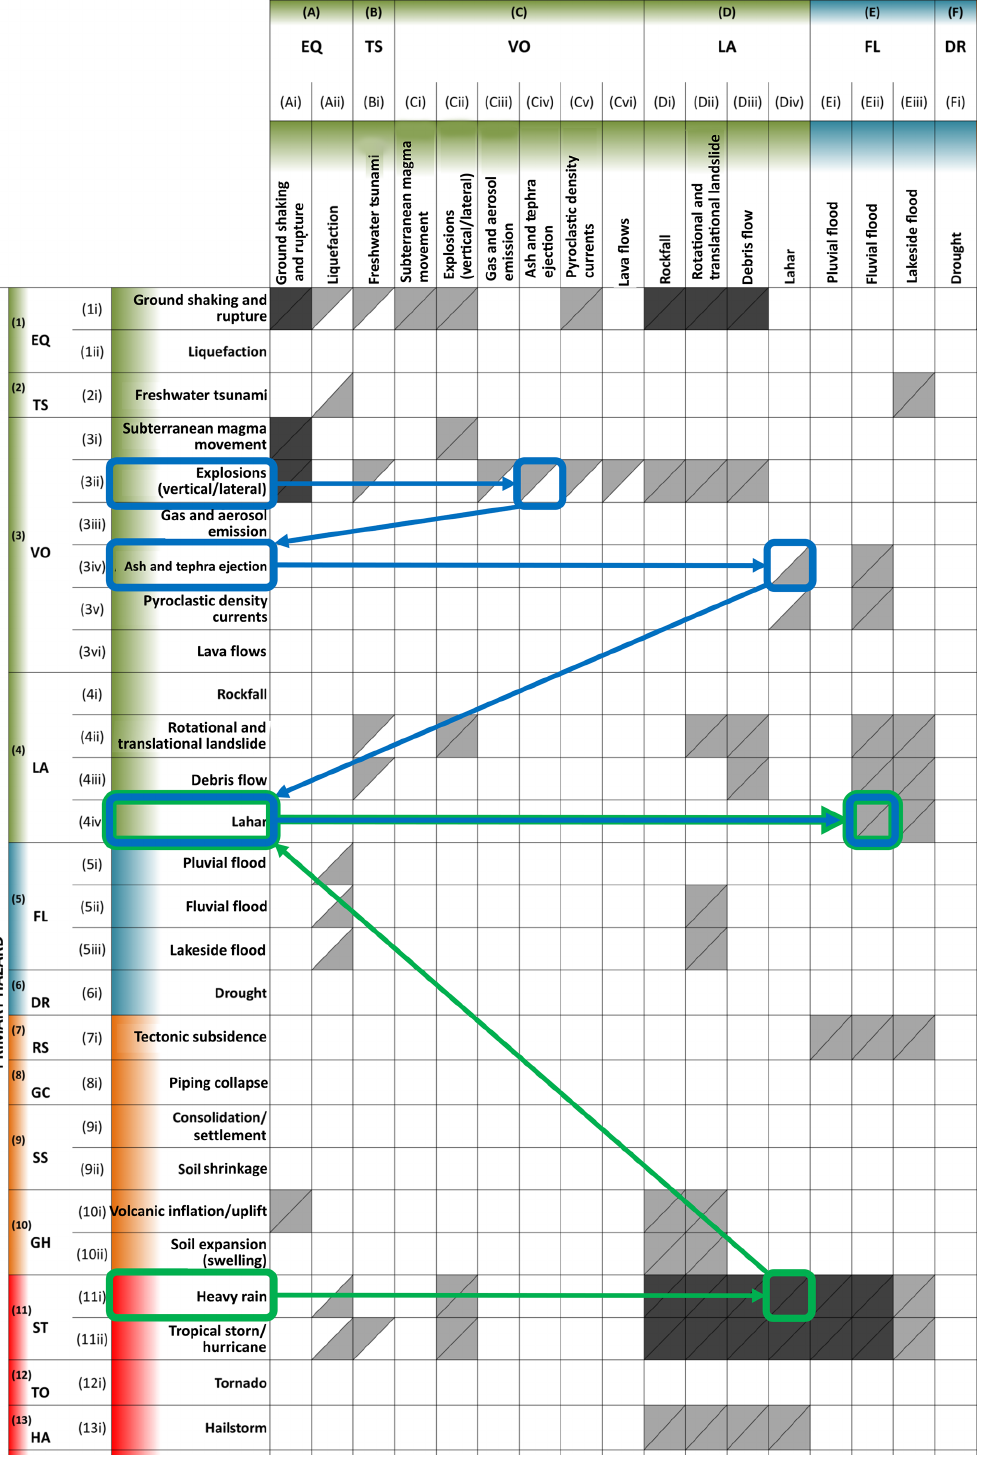
Figure 5. Network of hazard interactions (Example 1), southern Guatemalan Highlands, Guatemala. A 26 × 17 extract of the 33 × 33 sub- national interaction framework presented in Fig. 4, with a case-study example of a network of hazard interactions (cascade). This case study shows (i) volcanic explosions triggering the ejection of ash and tephra, (ii) ash and tephra increasing the likelihood of lahars, (iii) heavy rain (together with the existing tephra and ash) combining to trigger a lahar, and (iv) lahars triggering flooding. Evidence for this network is stated in the text. See Fig. 3 legend for symbols and